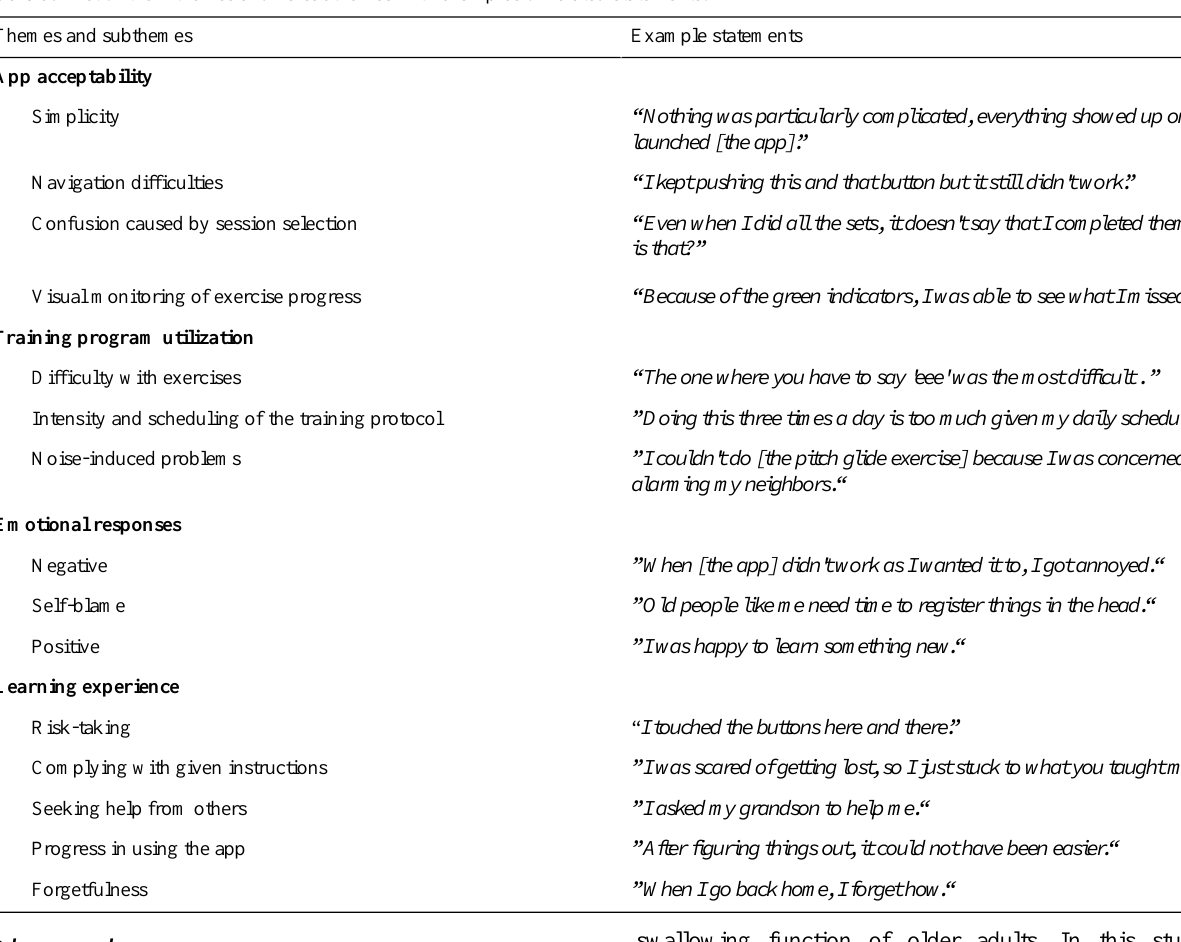
Table 6. List of the 4 themes and 15 subthemes with examples of related